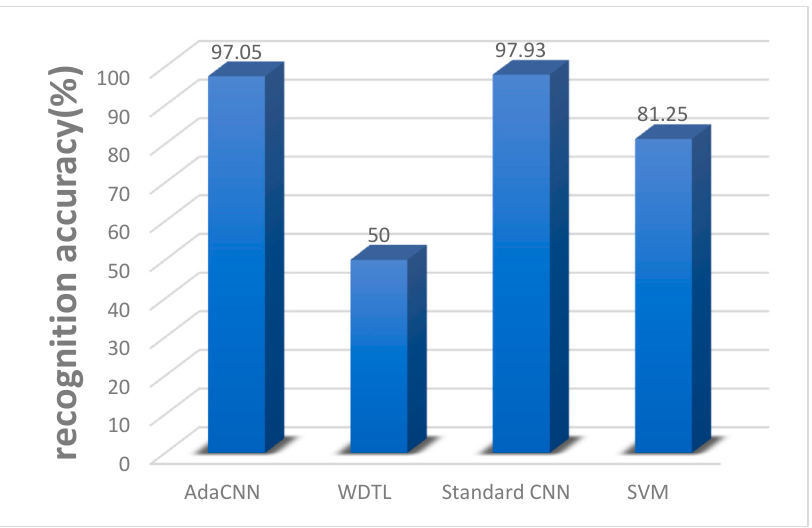
Figure 7. The correct rate of fault diagnosis between different locations.